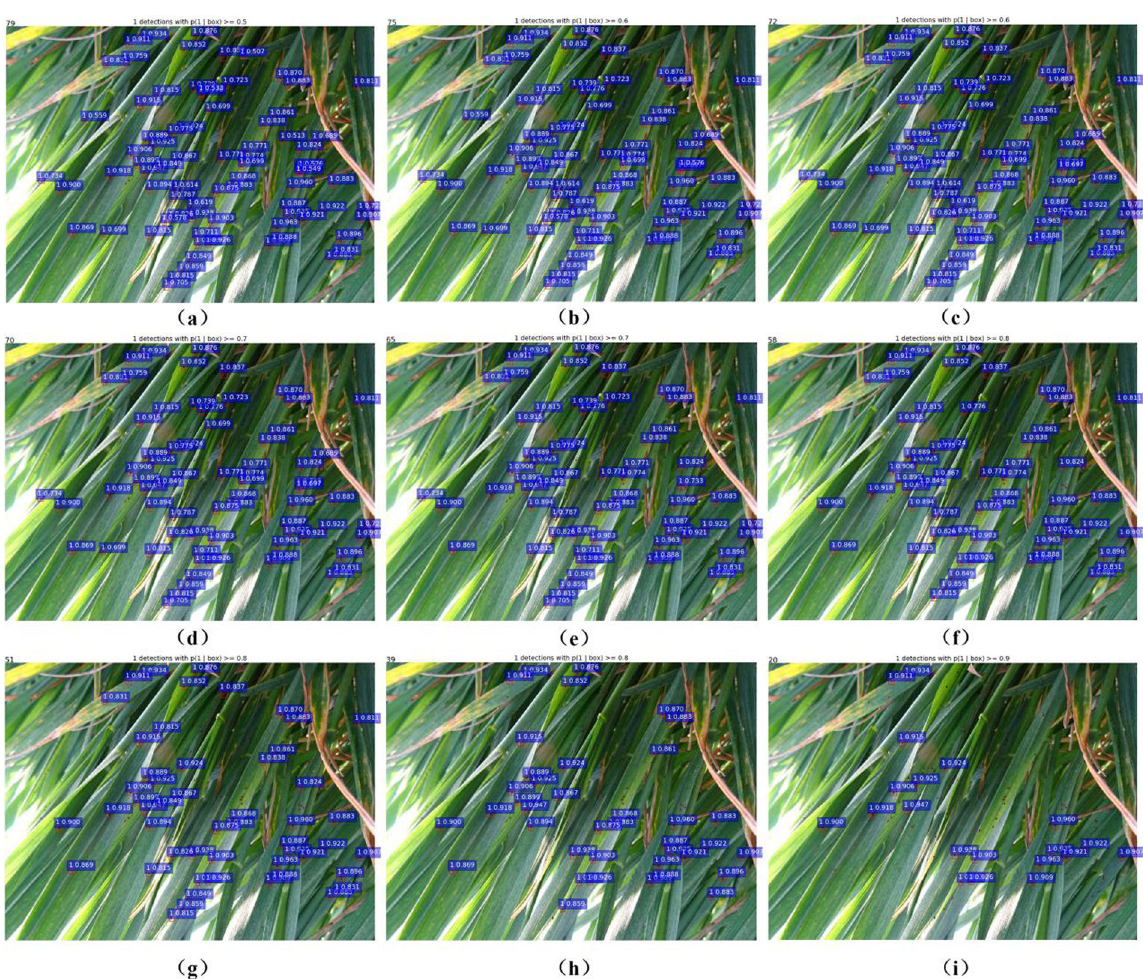
Figure 10. Case studies of a visual comparison of localization and counting results under different score thresholds, sth . ( a ) sth = 0.5, ( b ) sth = 0.55, ( c ) sth = 0.6, ( d ) sth = 0.65, ( e ) sth = 0.7, ( f ) sth = 0.75, ( g ) sth = 0.8, ( h ) sth = 0.85 and ( i ) sth = 0.9. NMS threshold is 0.5. All the images are from the dataset B stored with 1440 × 1080